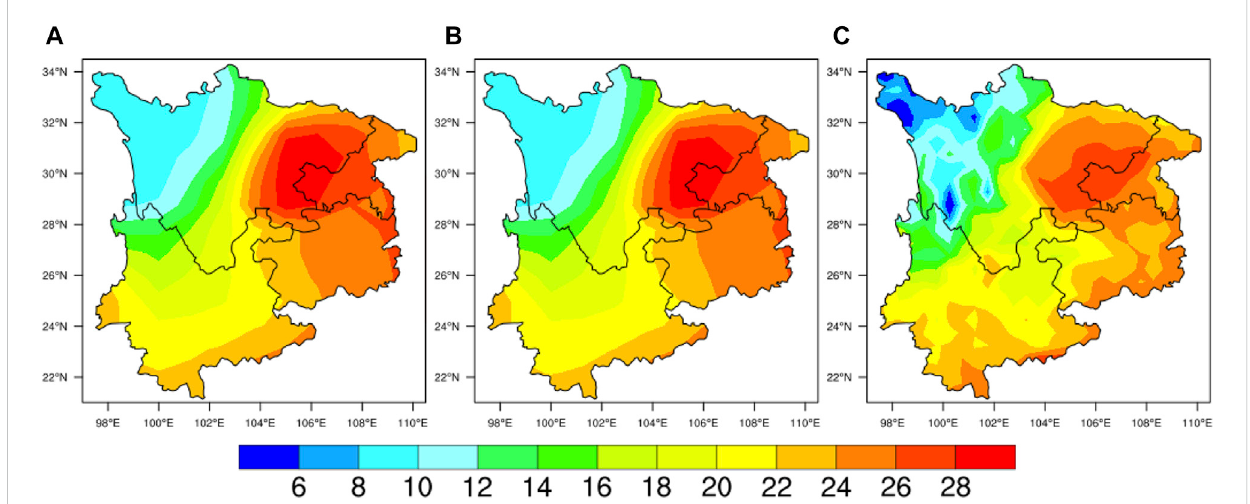
FIGURE 3 The2-mairmeantemperature(T 2m )resultsforsouthwestChinafrom1992to2013intheborealsummer(JJA): (A) controlmodelingresultswithout AHR; (B) modeling results with AHR; (C) CRU data results (unit: °